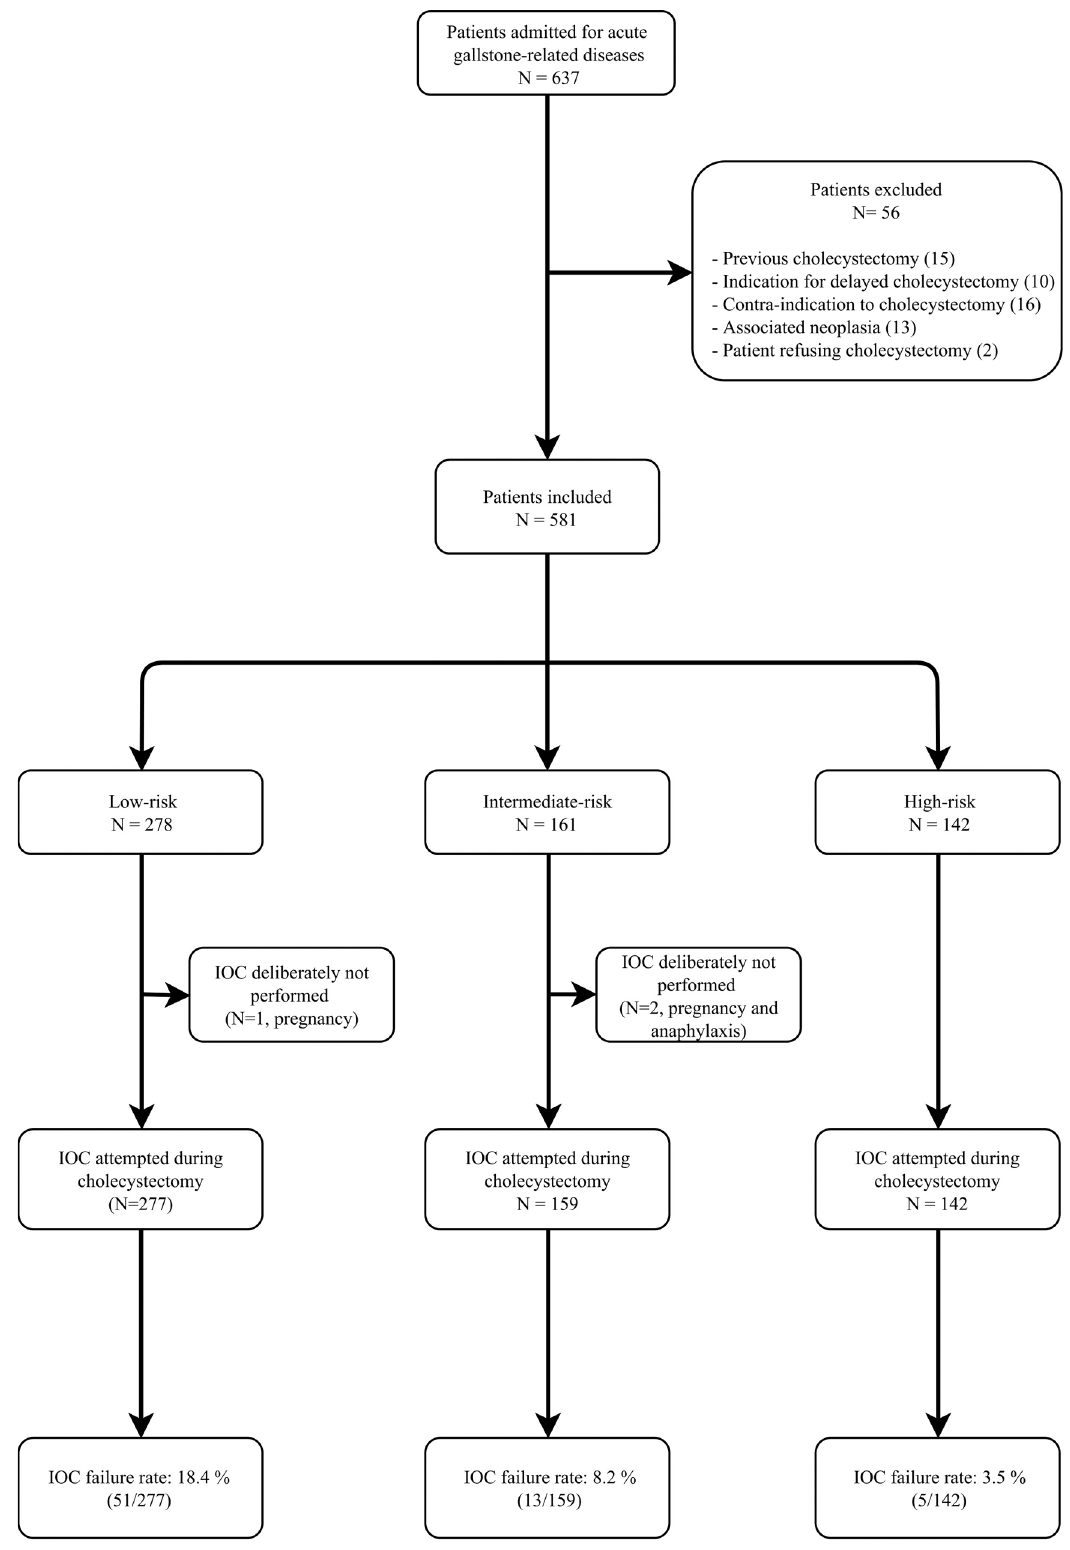
Fig 1. Flow-chart. IOC = intraoperative cholangiogram.